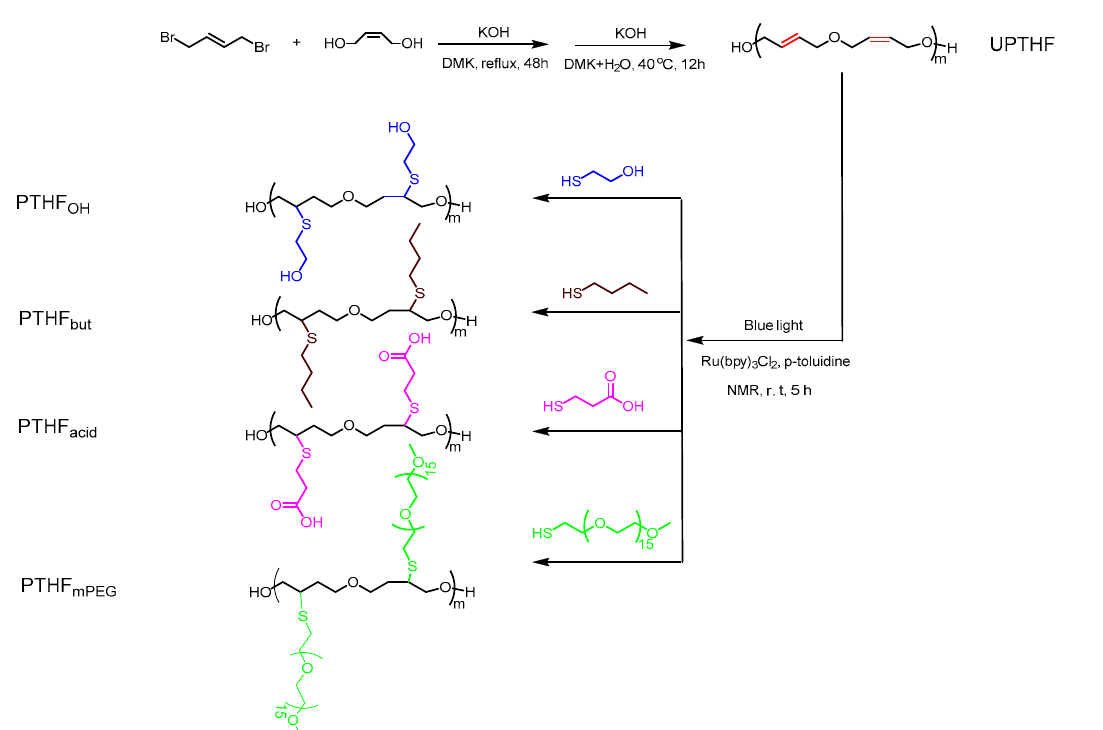
Figure 1. The synthesis routes of unsaturated polytetrahydrofuran (UPTHF) and side-chain functional polytetrahydrofuran (PTHF) derivatives.